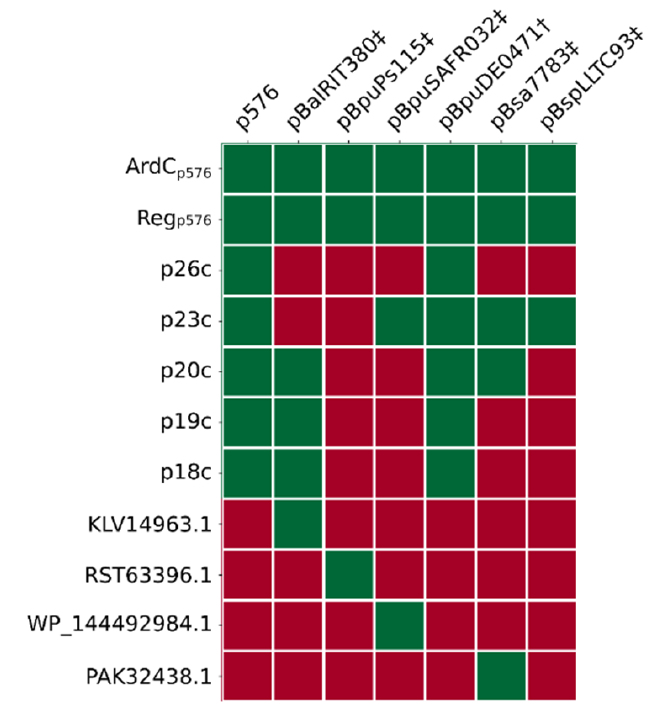
Figure 6. Conserved putative establishment proteins encoded by clade II plasmids of the pLS20 family. Homologous proteins indicated with green boxes were identified using the COG or OMCL algorithms of the tool “get homologues” with coverage and e-value thresholds of 75% and 1e-10, respectively.